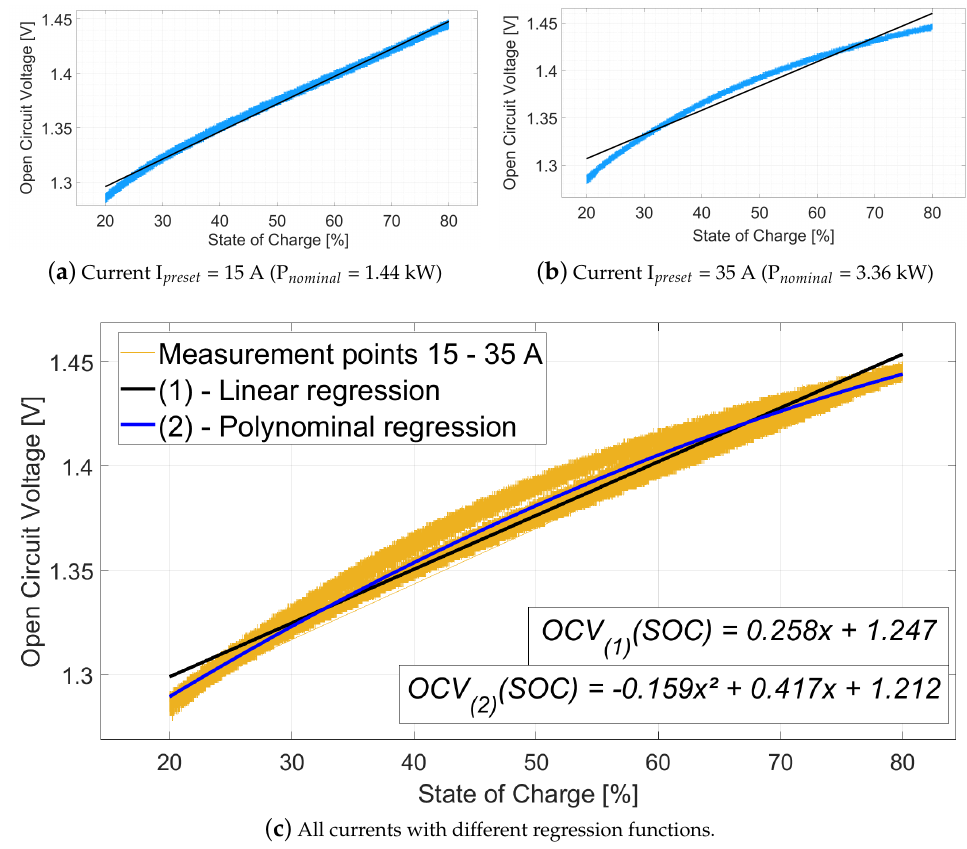
Figure 3. OCV–SOC relation results: ( a ) I preset 15 A; ( b ) I preset 35 A; ( c ) data points of all measurements from I preset 15 A to 35 A and different regression